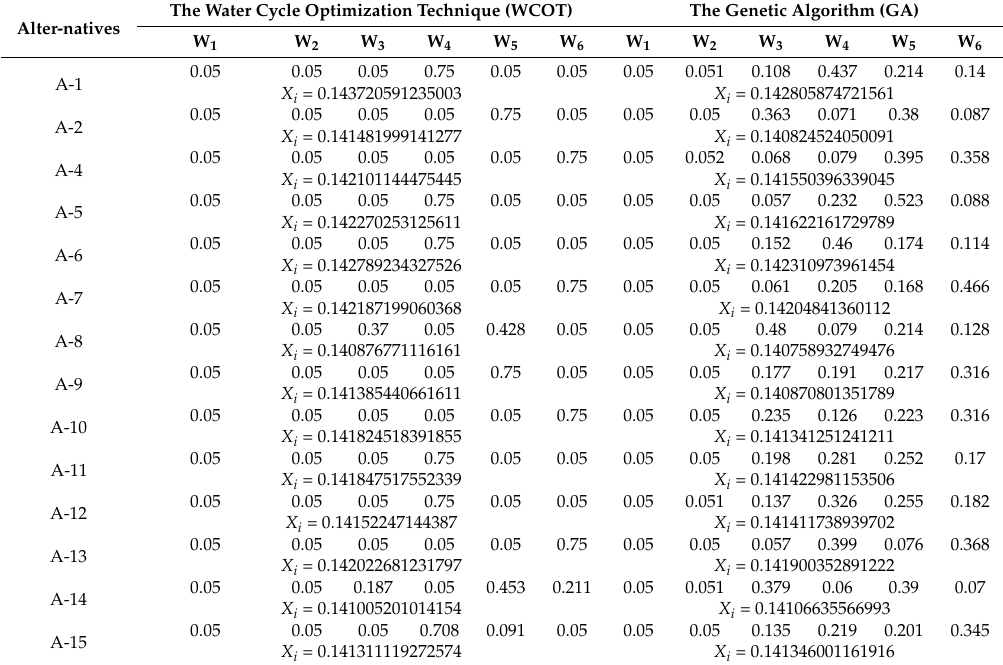
Table 5. Comparison between the Water Cycle Optimization Technique (WCOT) and the Genetic Algorithm (GA).